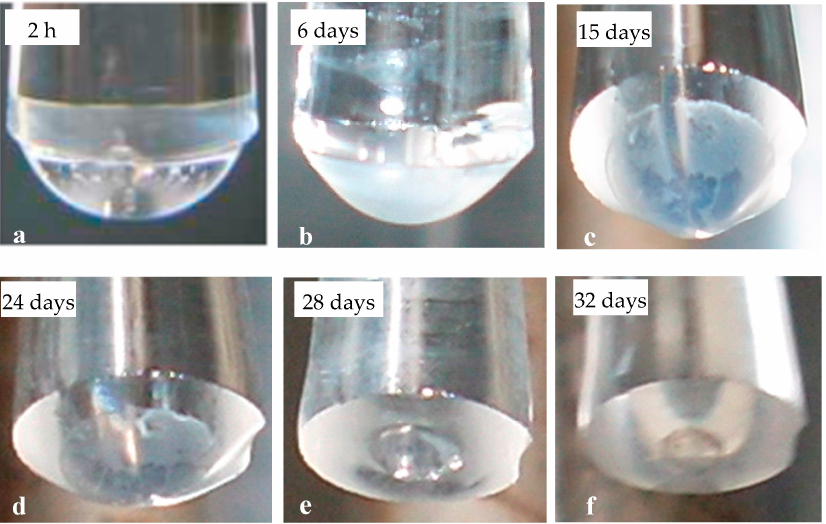
Figure 4. The fiber end with the silica hydrogel matrix ( a ) 2 h; ( b ) 6 days; ( c ) 15 days; ( d ) 24 days; ( e ) 28 days; and ( f ) 32 days after P. putida TVA8 immobilization and daily induction with toluene